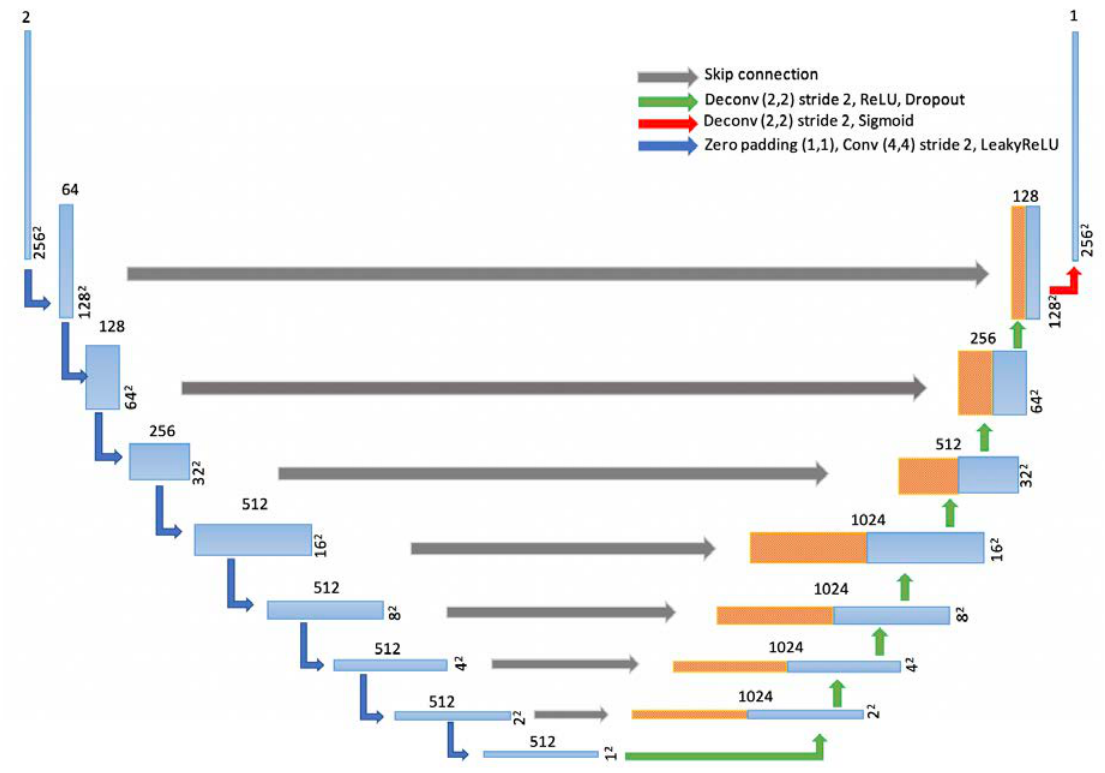
Figure 4. Detail of network